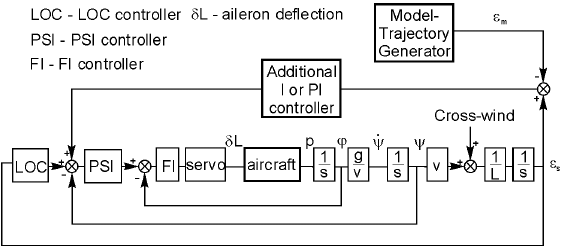
Fig 5. Illustration of the idea of usage model-following control Unfortunately, simulations proved that the system shown in figure 5 is very sensitive to differences between the aircraft model used for the generation of a trajectory and the “real” aircraft. The smallest differences appear during straight-line flight, so the idea of the control system presented in figure 5 was used during